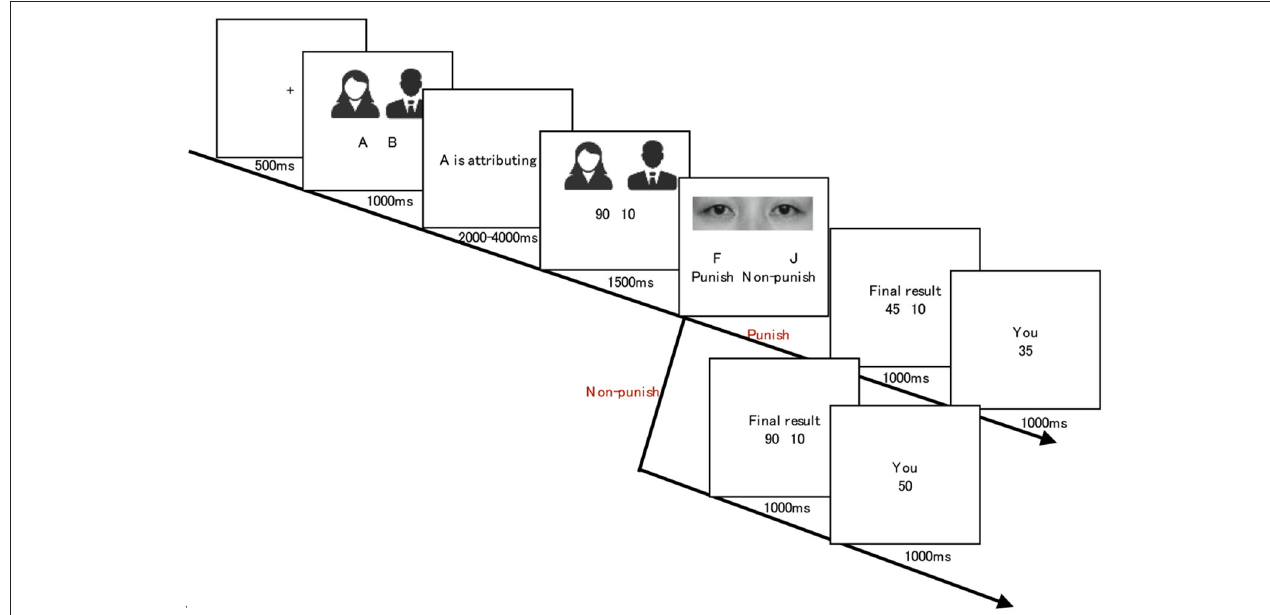
FIGURE 1 | Example of one trial. The picture shows in eyes condition, results of punish or non-punish.